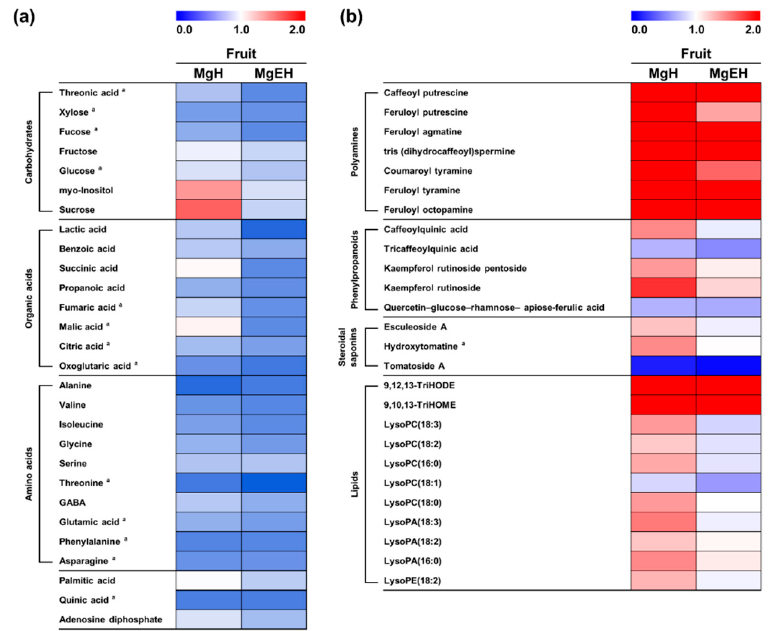
Figure 4. Heat map representation of the relative abundance of significantly discriminant fruit metabolites (VIP > 0.7) based on the fruit PLS-DA model (Figure 2c). The values represent the fold change with respect to control. a indicates significant differences ( p -value < 0.05) between the control and each treatment. ( a ) Primary and ( b ) secondary metabolite data derived from GC-TOF-MS and UHPLC-LTQ-Orbitrap-MS, respectively.